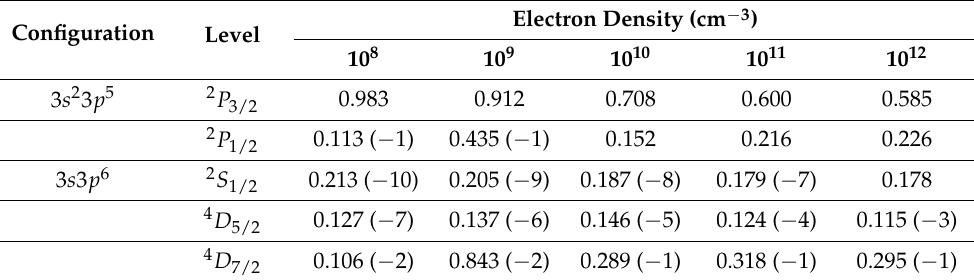
Table 13. Level populations of the lowest five levels in Fe X. Configuration